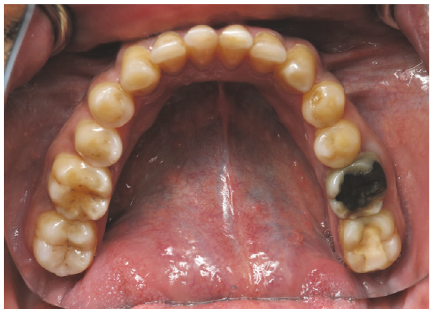
Figure 2: Dental erosions on cusps of canines and premolars in the mandibular arch.